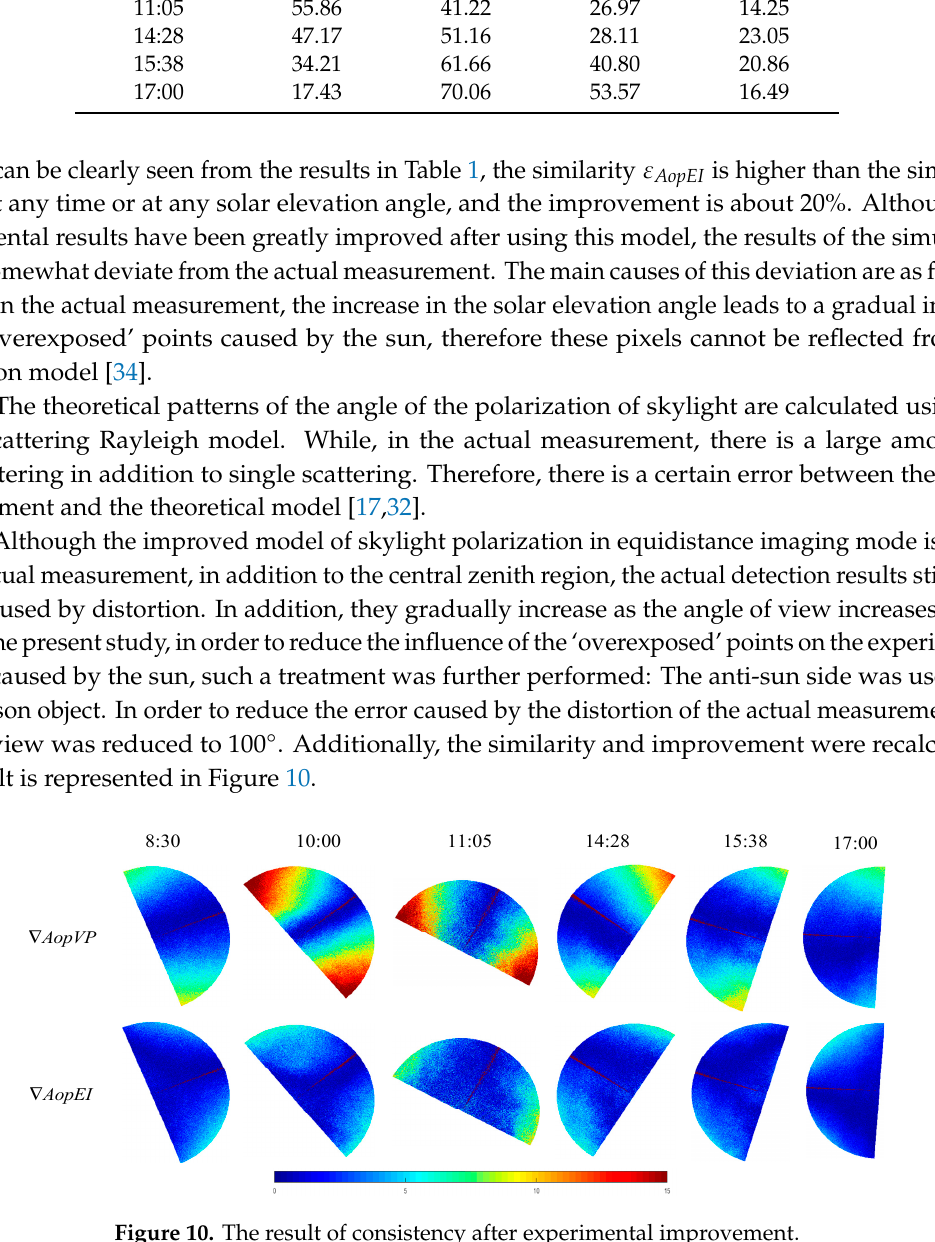
Table 2. Similarity and degree of improvement after experimental improvement.